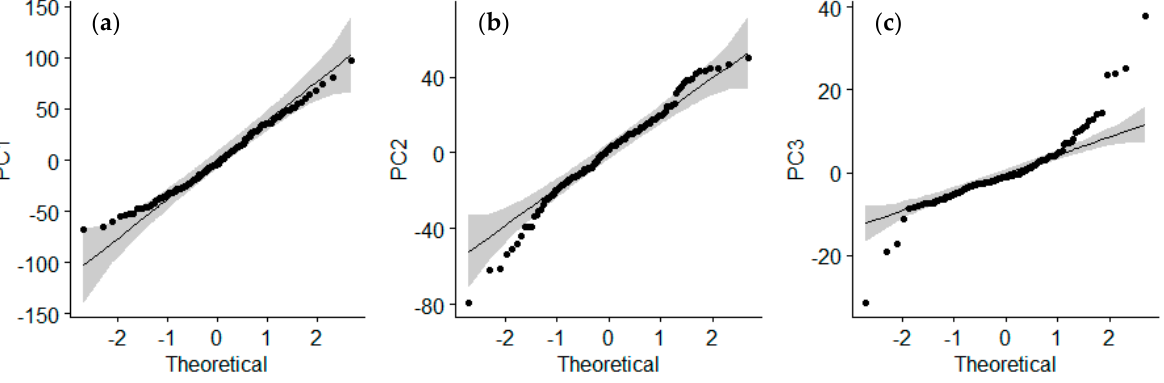
Figure 3. Quantile ‐ Quantile plots for PC1 ( a ), PC2 ( b ), and PC3 ( c ). The black line represents a perfectly normal distribution, the shaded grey shape represents the 95% confidence interval within the real distribution (Black dots) should stay.